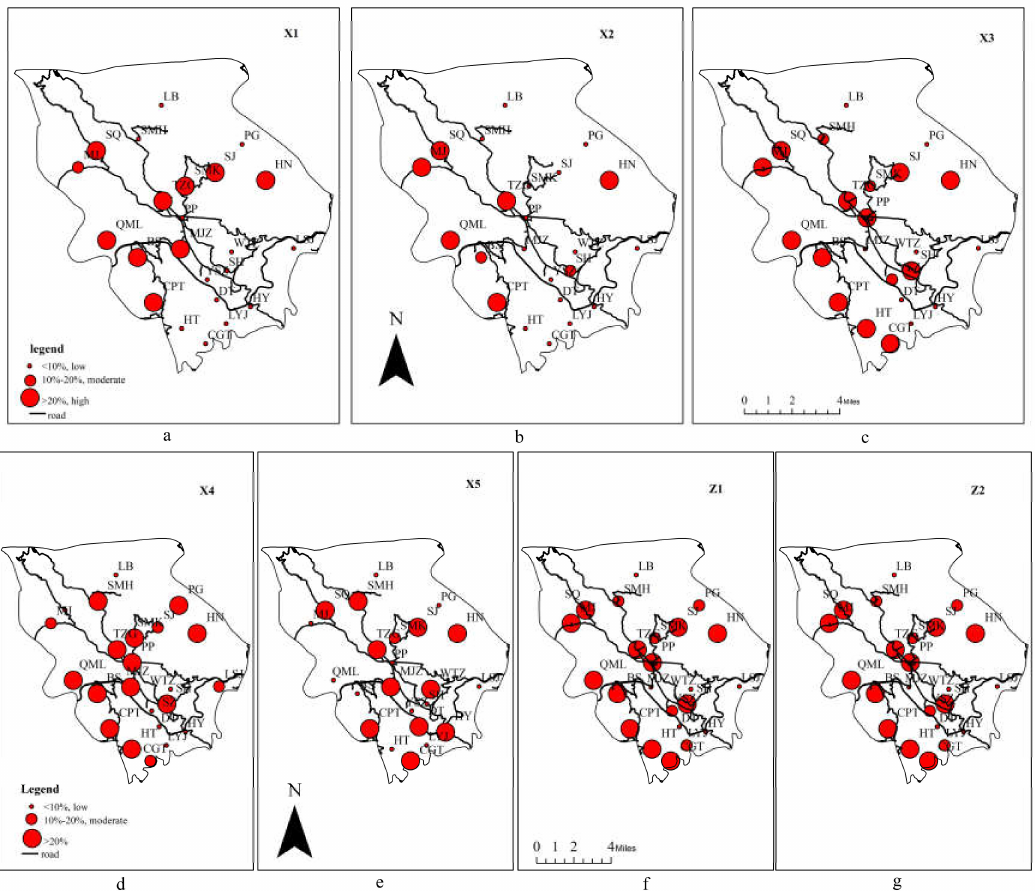
Figure 4. The main reasons for eco-e ffi ciency loss. ( a ) The reducible proportion of X1; ( b ) The reducible proportion of X2; ( c ) The reducible proportion of X3; ( d ) The reducible proportion of X4; ( e ) The reducible proportion of X5; ( f ) The reducible proportion of Z1; ( g ) The reducible proportion of